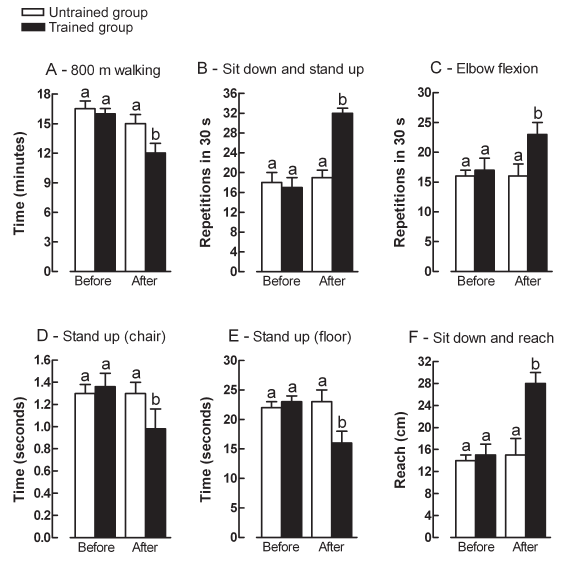
Figure 1 - Functional capacity before, and 6 months after, physical exer- cise evaluated by fitness tests involving aerobic conditioning (Panel A); strength of lower (Panel B) and upper limbs (Panel C); agility (Panels D and E); and joint flexibility (Panel F). Different letters indicate statistically significant differences between the groups (p < 0.05). Data are expressed as the mean ± SD